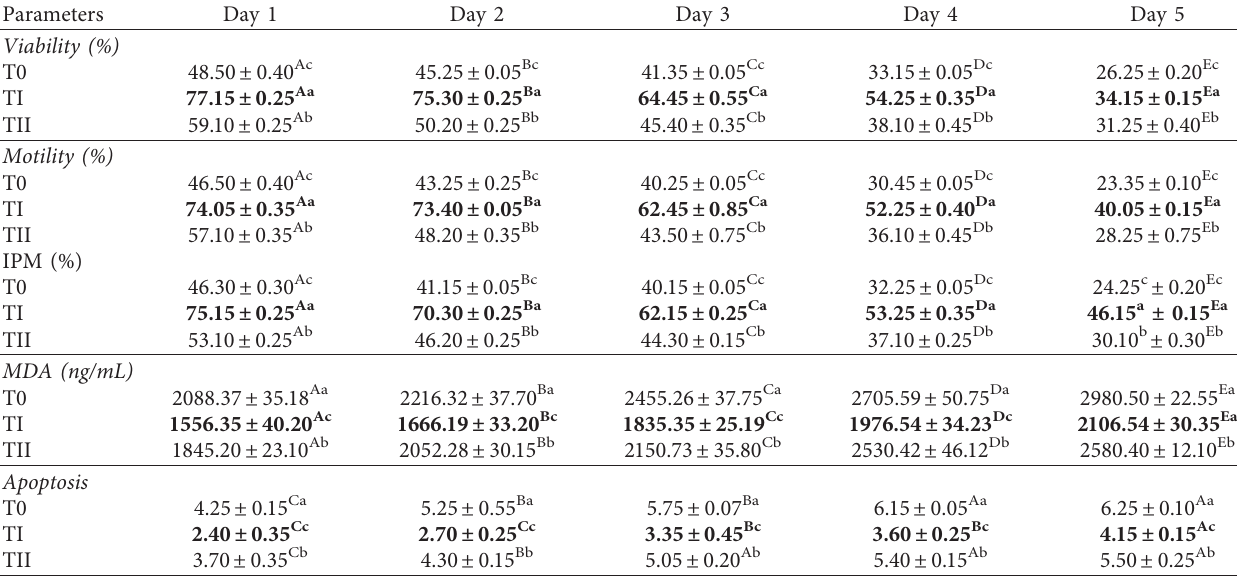
Different capital letter superscripts in the same row and lowercase letter superscripts in the same column indicate significant differences ( p < 0 . 05). SM-EY: skim milk-egg yolk; T0: SM-EY extender without the protein; T1: SM-EY extender +12 μ g protein/100mL extender; T2: SM-EY extender +24 μ g protein/